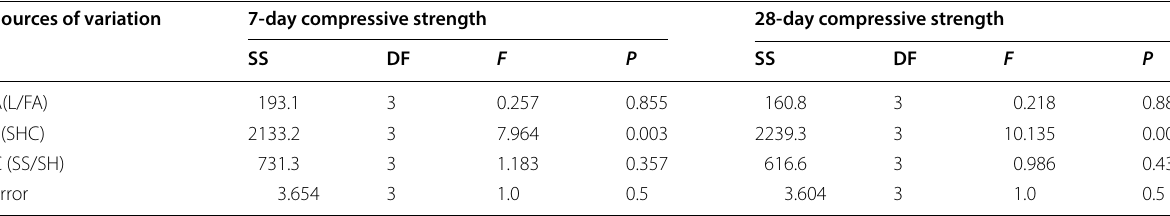
Table 9 The variance analysis on 7- and 28-day compressive strength. Sources of variation 7-day compressive strength 28-day compressive